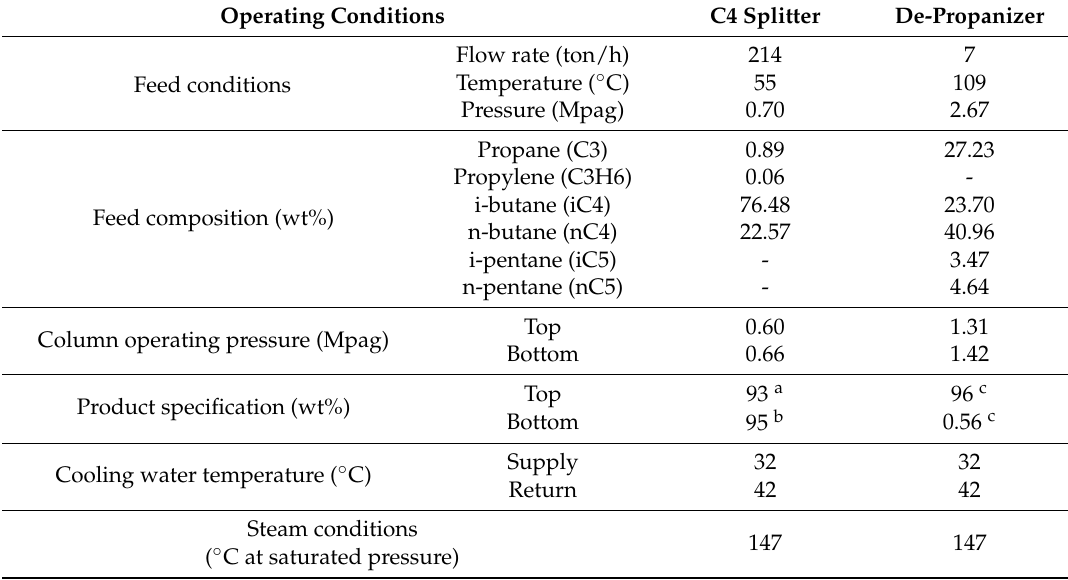
Table 1. Feed conditions, operating conditions, and product specifications of the columns considered in this